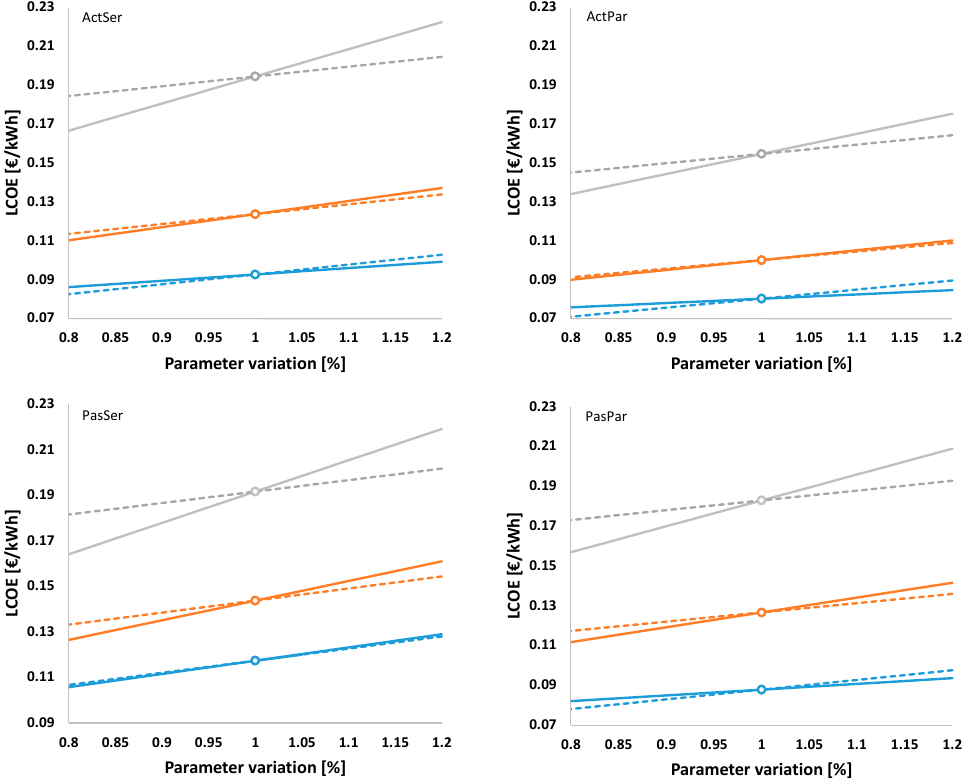
Figure 17. E ff ect of varying ICs (solid lines) and OCs (dash lines) for the economical (blue), the compromise (orange) and the most e ffi cient (gray) designs of ActSer, ActPar, PasSer and PasPar.